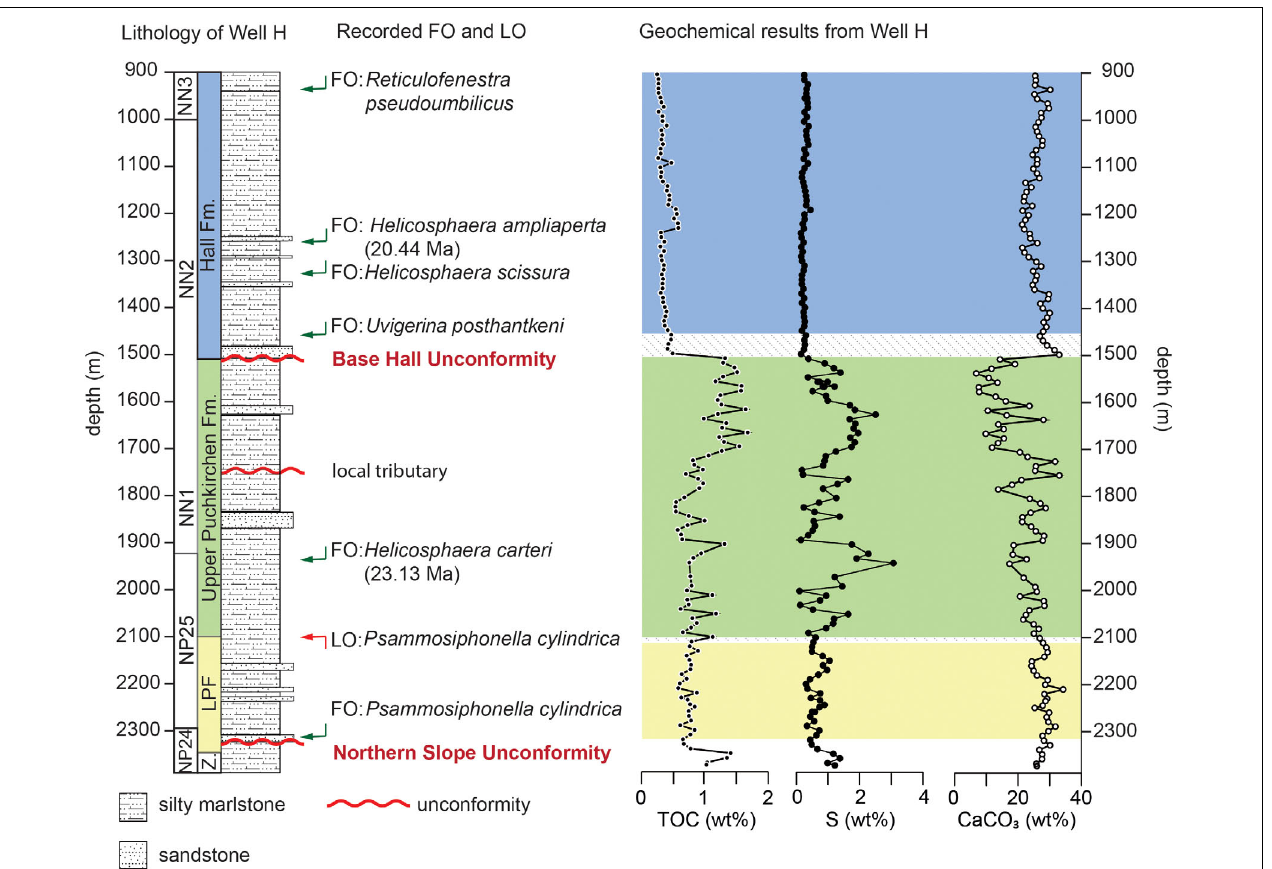
FIGURE 5 | Simplified lithological section of Well H (see Figure 1 for location) with FO and last occurrence (LO) of index taxa (nannofossils and benthic foraminifera). Total organic carbon (TOC) and sulfur (S) increase from moderate levels with low variance in the LPF (from 2100 m) to very high levels in the upper half of the UPF showing great variance, indicating highly unstable ecologic conditions. Above the BHU, TOC, and S values drop to very low and stable levels, while CaCO 3 dramatically increases. Uncertainties are due to sampling resolution and preservation. See text for